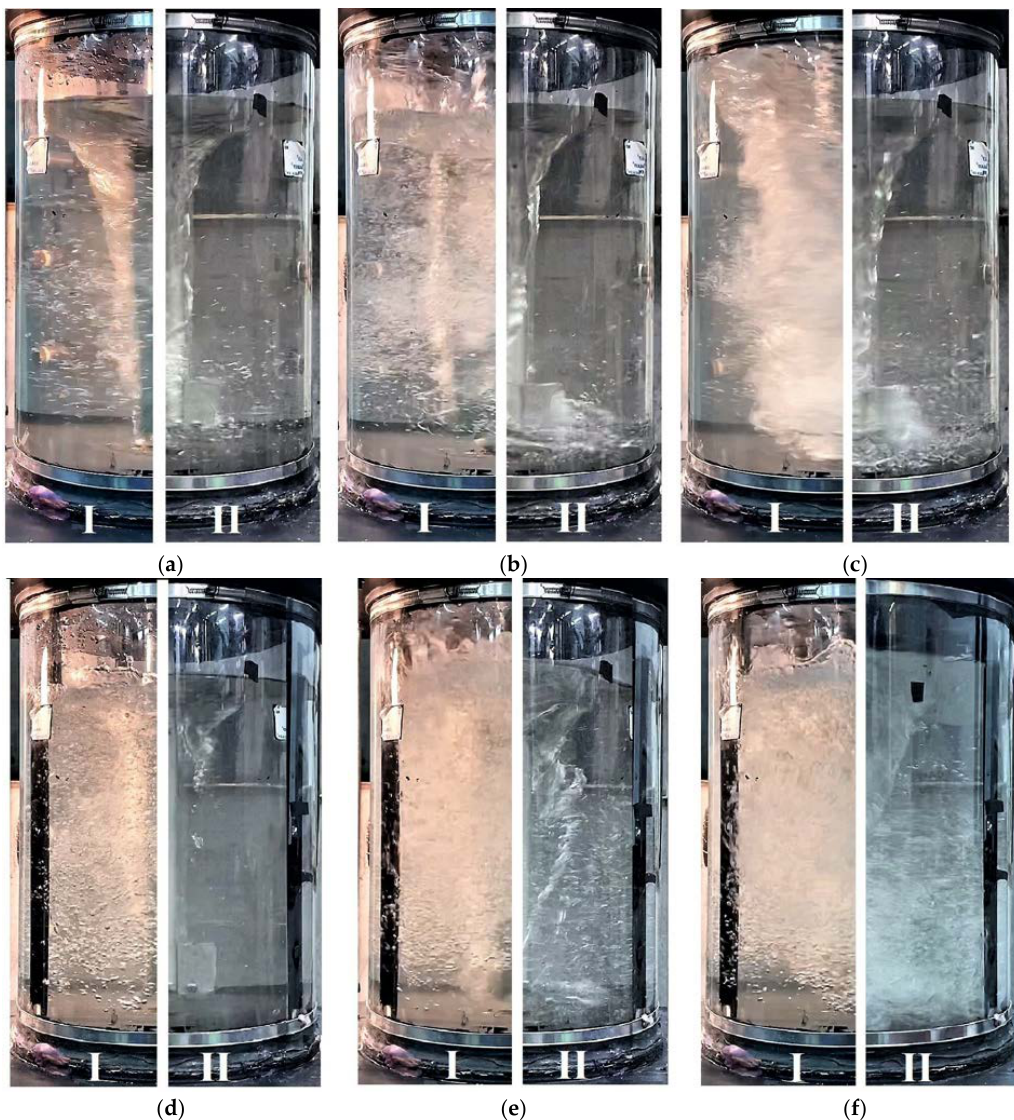
Figure 4. View of the gas–liquid medium in the apparatus without partitions ( a – c ) and with two partitions ( d – f ) with a change in the rotational speed at H L / D = 1.2, D = 0.28 (m), d s = 0.064 (m), b = 0.025 (m), h = 0.3 (m) (I), and h = 0.05 (m) (II): ( a , d ) 600 (rpm); ( b , e ) 900 (rpm); ( c , f ) 1200